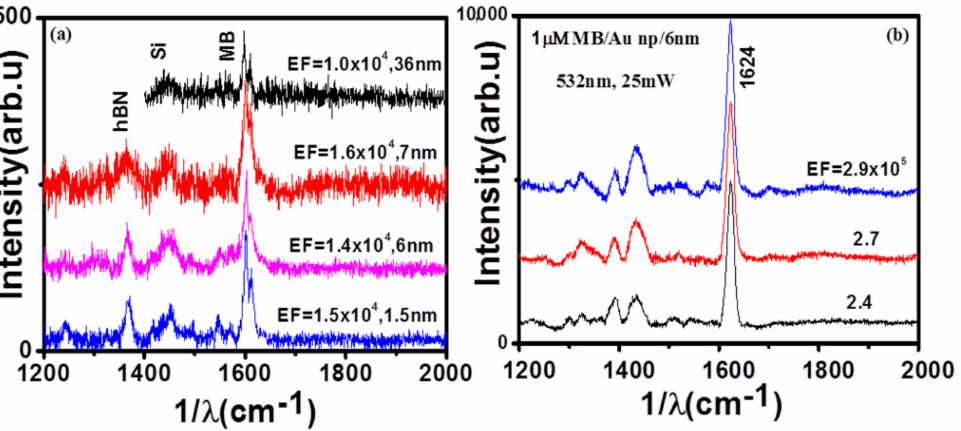
Figure 5. ( a ) Comparison of Raman enhancement of 1 µ M MB using CVD hBN films of thickness 1.5, 6, and 7 nm film and exfoliated hBN flakes of 36 nm thickness. ( b ) Raman enhancement of 1 micromolar MB with Au nanoparticles and hBN.